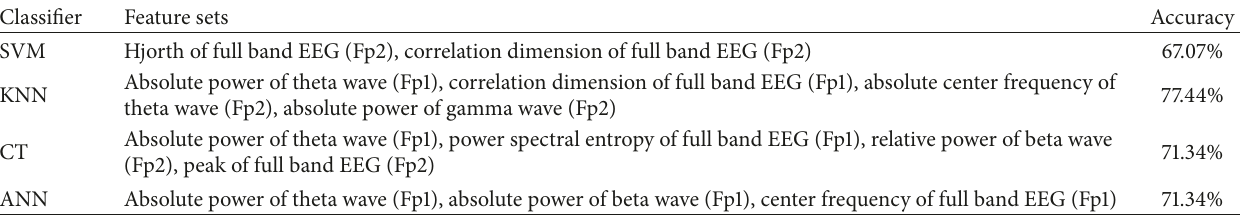
Table 6: Classification results in negative audio stimulation